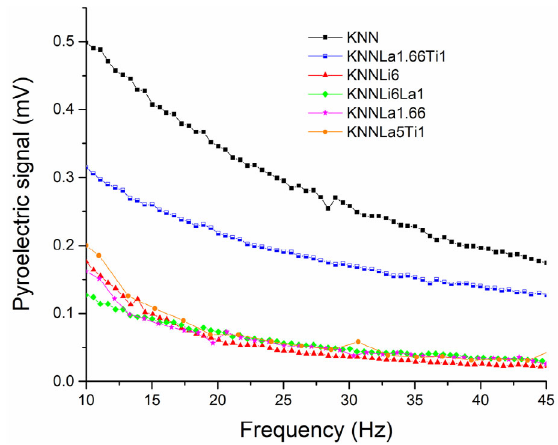
Fig. 9 Pyroelectric response of ceramic samples. All samples were polarized under the application of an electric field of 16.6 kV/cm for 30